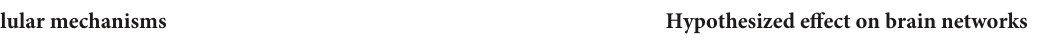
TABLE 1 Summary of the cellular mechanisms found in schizophrenia and their suggested effect on the brain. Cellular mechanisms